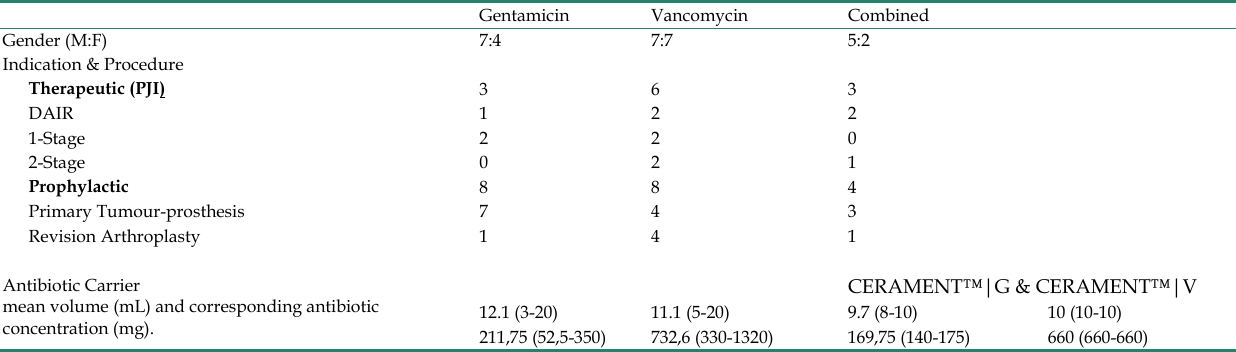
Table 1 . Treatment characteristics in 32 cases with locally implanted Gentamicin and/or Vancomycin in a commercially available antibiotic carrier (CERAMENT™)